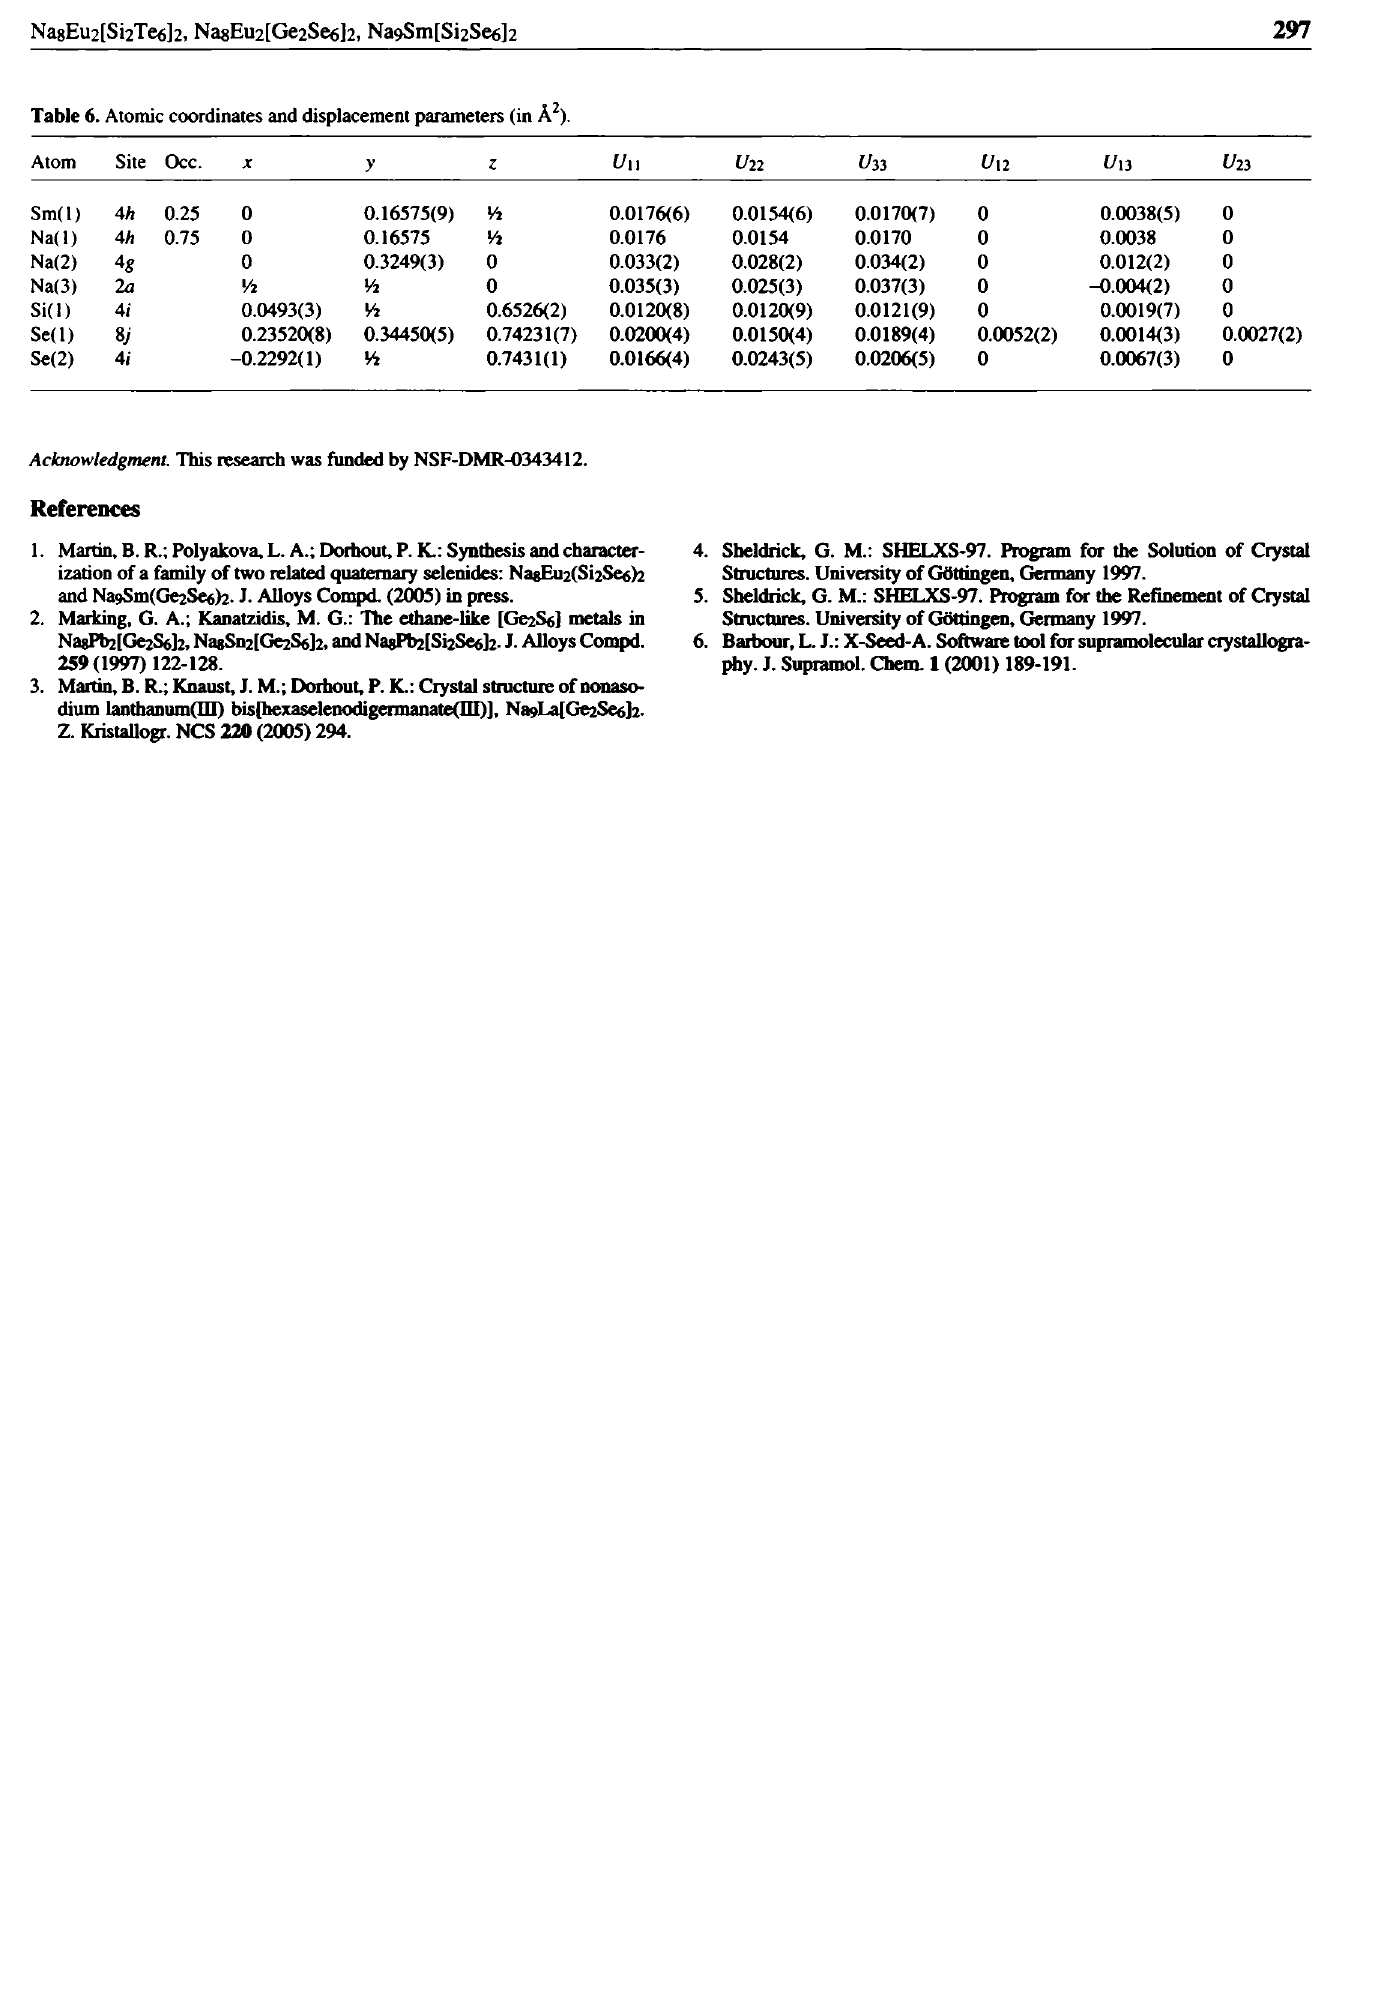
Table 6. Atomic coordinates and displacement parameters (in A 2